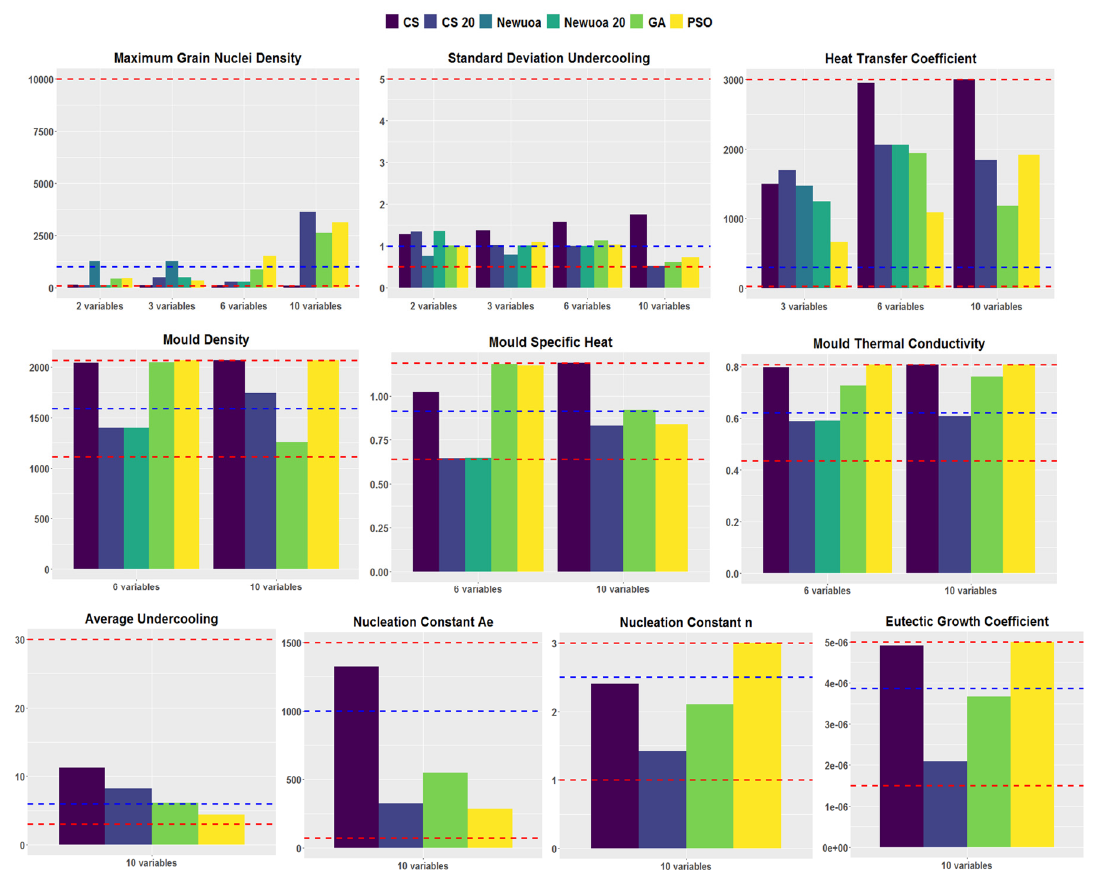
Figure 10. Values assigned to variables grouped by the number of variables included in the fitting and colored by the algorithm.